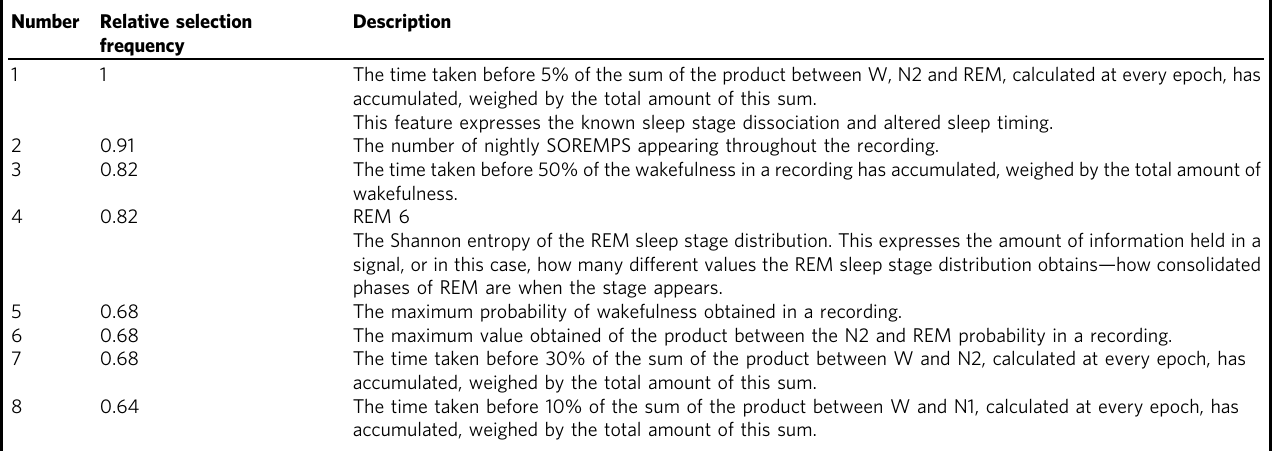
Table 4 Descriptions of the 8 most frequently selected